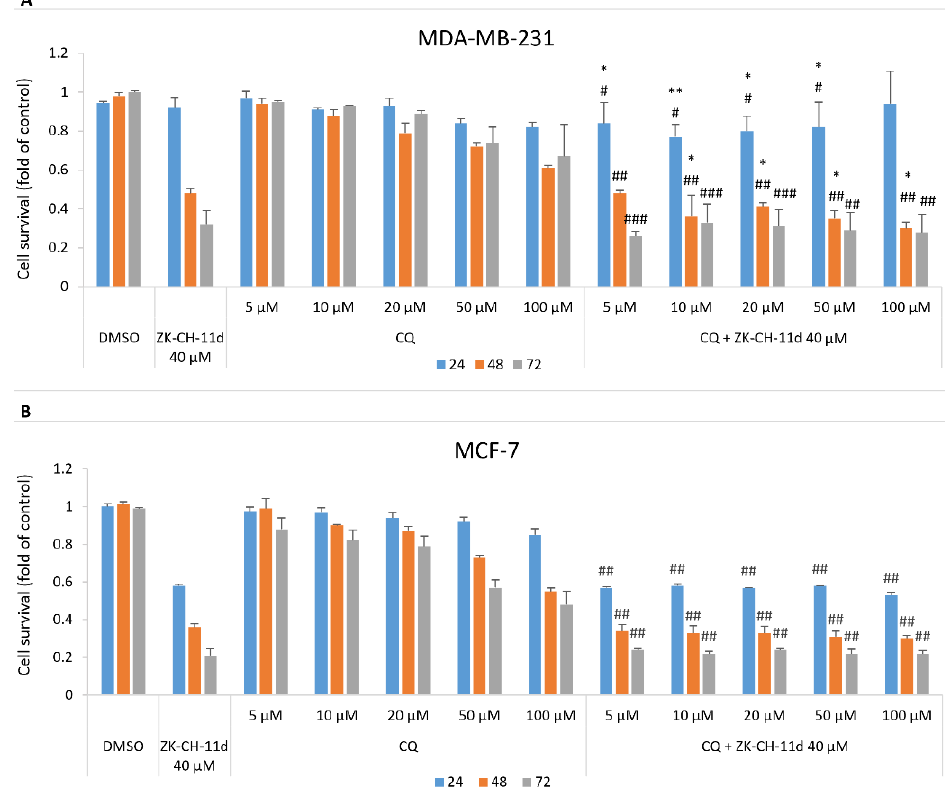
Figure 19. Effect of ZK-CH-11d and chloroquine on the proliferation of MDA-MB-231 ( A ) and MCF-7 ( B ) cells after 24, 48, and 72 h. The data are the results of three independent experiments. Values represent the mean ± standard deviation. Statistical significance: * p < 0.05, ** p < 0.01, vs. ZK-CH-11d; # p < 0.05, ## p < 0.01, ### p < 0.001 vs. chloroquine.